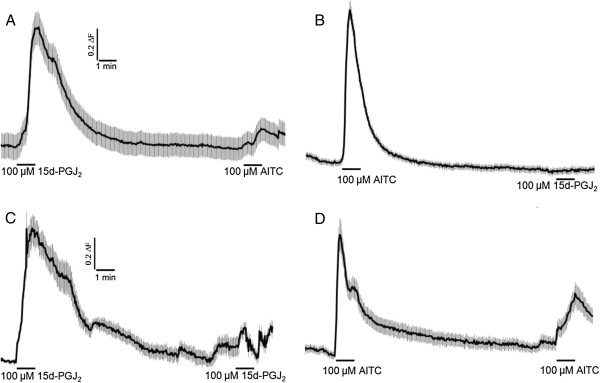
Homologous and heterologous inhibition evoked by 100 μM 15d-PGJ2 vs. 100 μM AITC. A pre-pulse of 100 μM 15d-PGJ2 desensitized subsequent responses to 100 μM AITC (A) and (B). Similarly, 100 μM AITC desensitized subsequent responses to 100 μM 15d-PGJ2 and 100 μM AITC. Interstimulus intervals of 4–8 minutes were tested (8 min shown in A-D). Traces show mean ± SEM of 10–30 neurons.